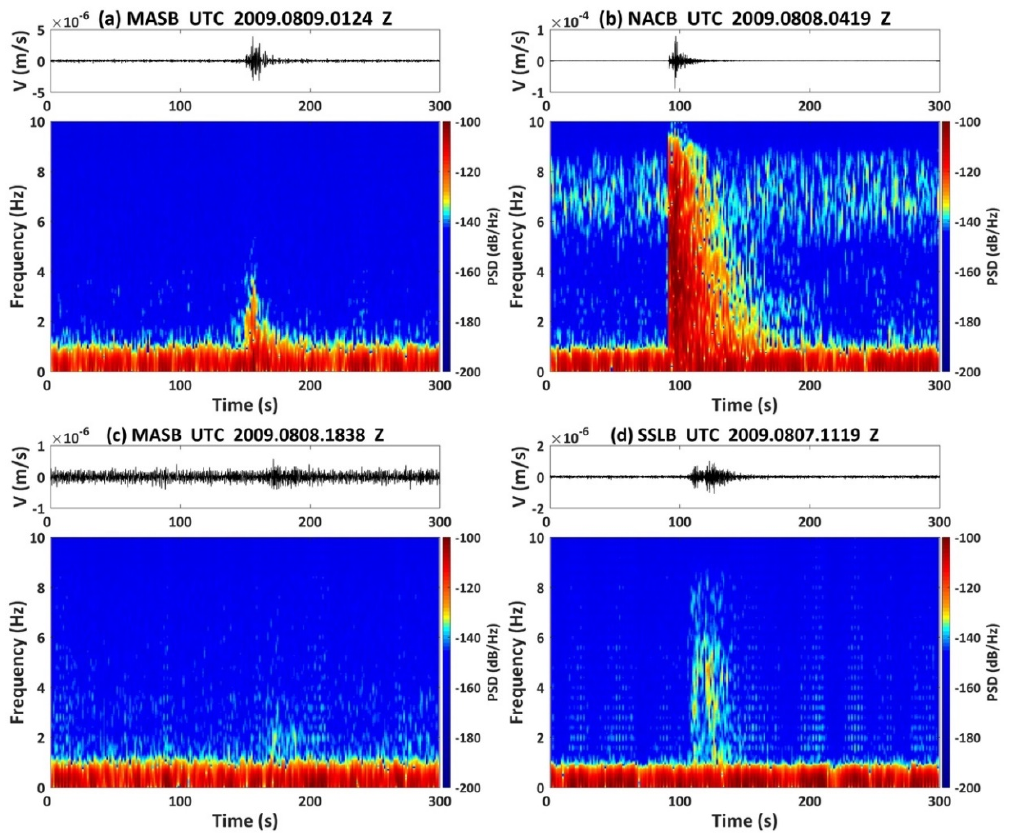
Figure 10. ( a ) A signal classified correctly as a landslide-quake; ( b ) a signal classified correctly as an earthquake; ( c ) a landslide-quake signal classified as noise; ( d ) an earthquake signal classified as a landslide-quake.